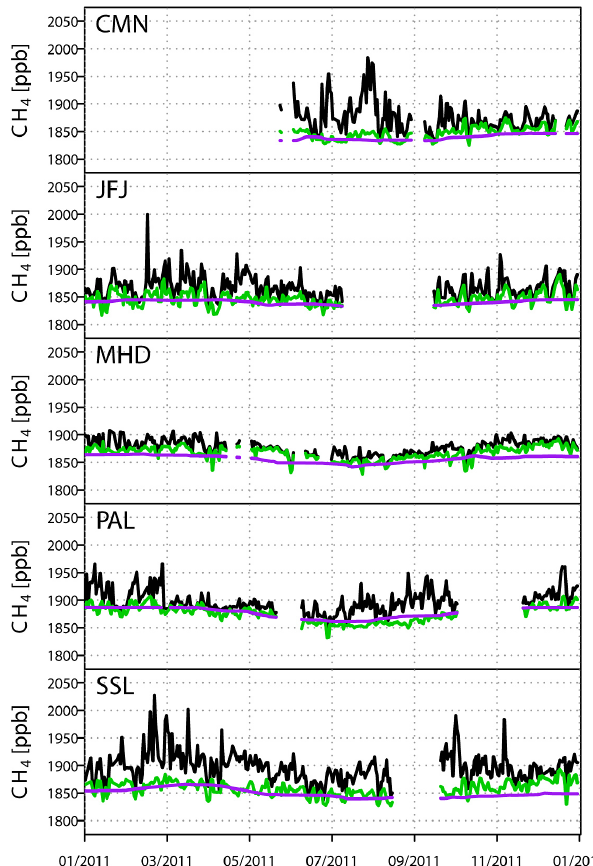
Figure 4. Comparison of the background CH 4 mole fraction, cal- culated using the observation-based (purple) and the model-based methods (green), with the observed mixing ratio (black).